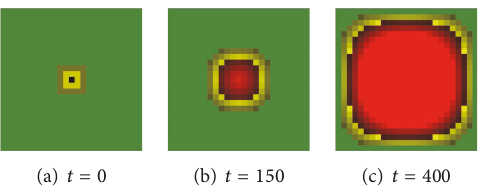
Figure 5: Execution of a simple fire spreading model on a 25 × 25 grid of cells at times 0 (a), 150 (b), and 400 (c).